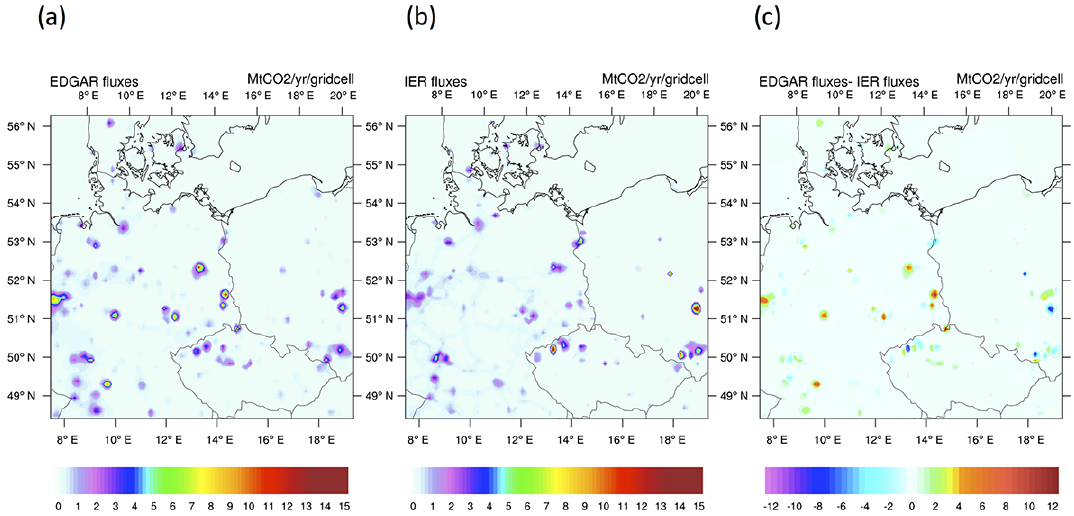
Figure 2. Annual averages of fossil fuel combustion emission fluxes at 10km × 10km, zoomed over the Berlin region: (a) EDGAR emissions, (b) IER emissions, and (c) the difference between EDGAR and IER emissions (EDGAR − IER). All units are in MtCO 2 yr − 1 per grid